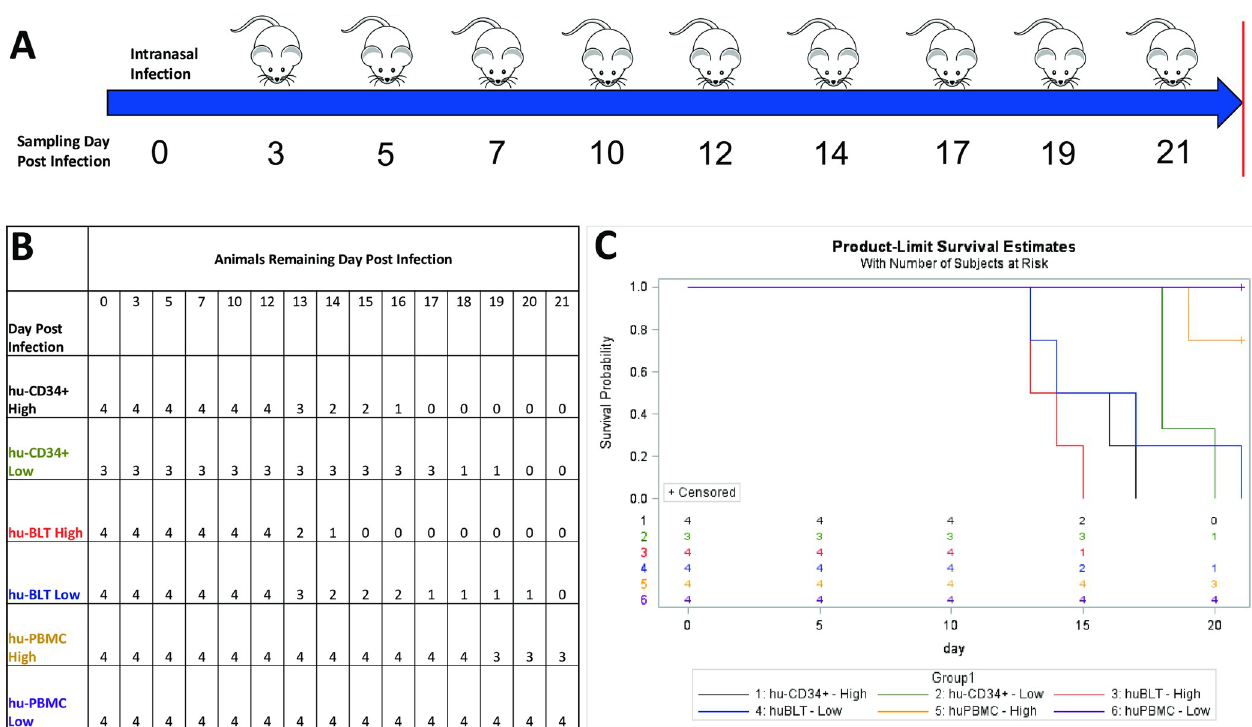
Fig 1. Study design, survival table and survivorship curves for mice and dosage groups. A schematic overview of the study design (A). The number of the three types of humanized mice per group based on days post infection and organized by dose group and mouse strain (B). If a sample day is not shown, there was no change in animal number per group. If a mouse was found deceased in-between PM and AM checks, the animal number was decreased the day the animal was found to have succumbed. Survival of three types of humanized mice (hu-BLT, hu-CD34+, and hu-PBMC) were assessed for low dose and high dose independently (C). � Hu-PBMC mice were significantly more likely to survive variola infection compared to hu-BLT and hu-CD34+ mice in both dose groups (high dose p = 0.004, low dose p = 0.008). There were no significant differences between hu-BLT and hu-CD34+ mice, when controlling for dose.